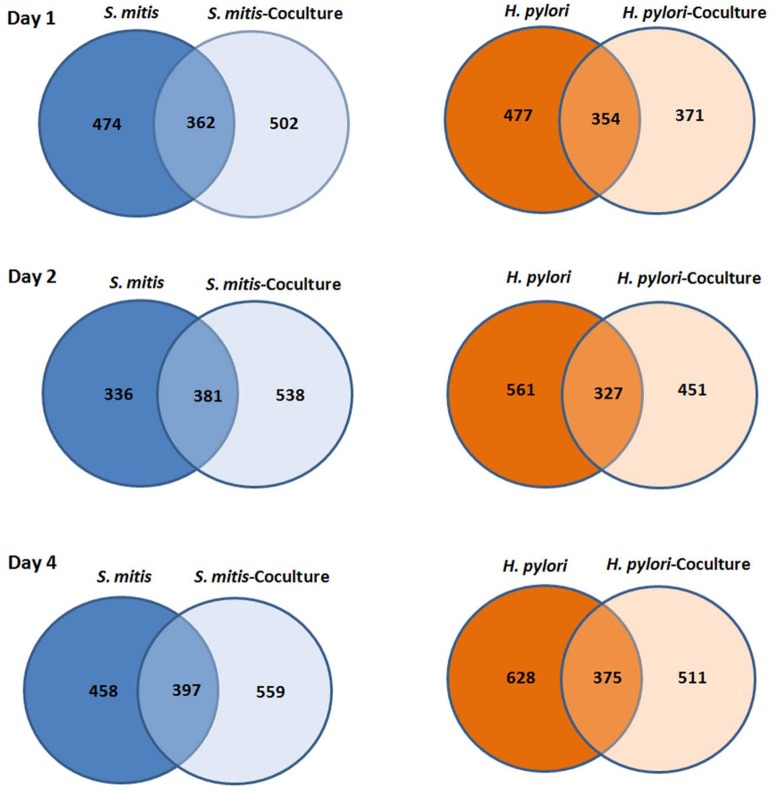
Venn diagram of number of proteins H. pylori and S. mitis found in mono and co-cultures at day 1, 2, and 4.